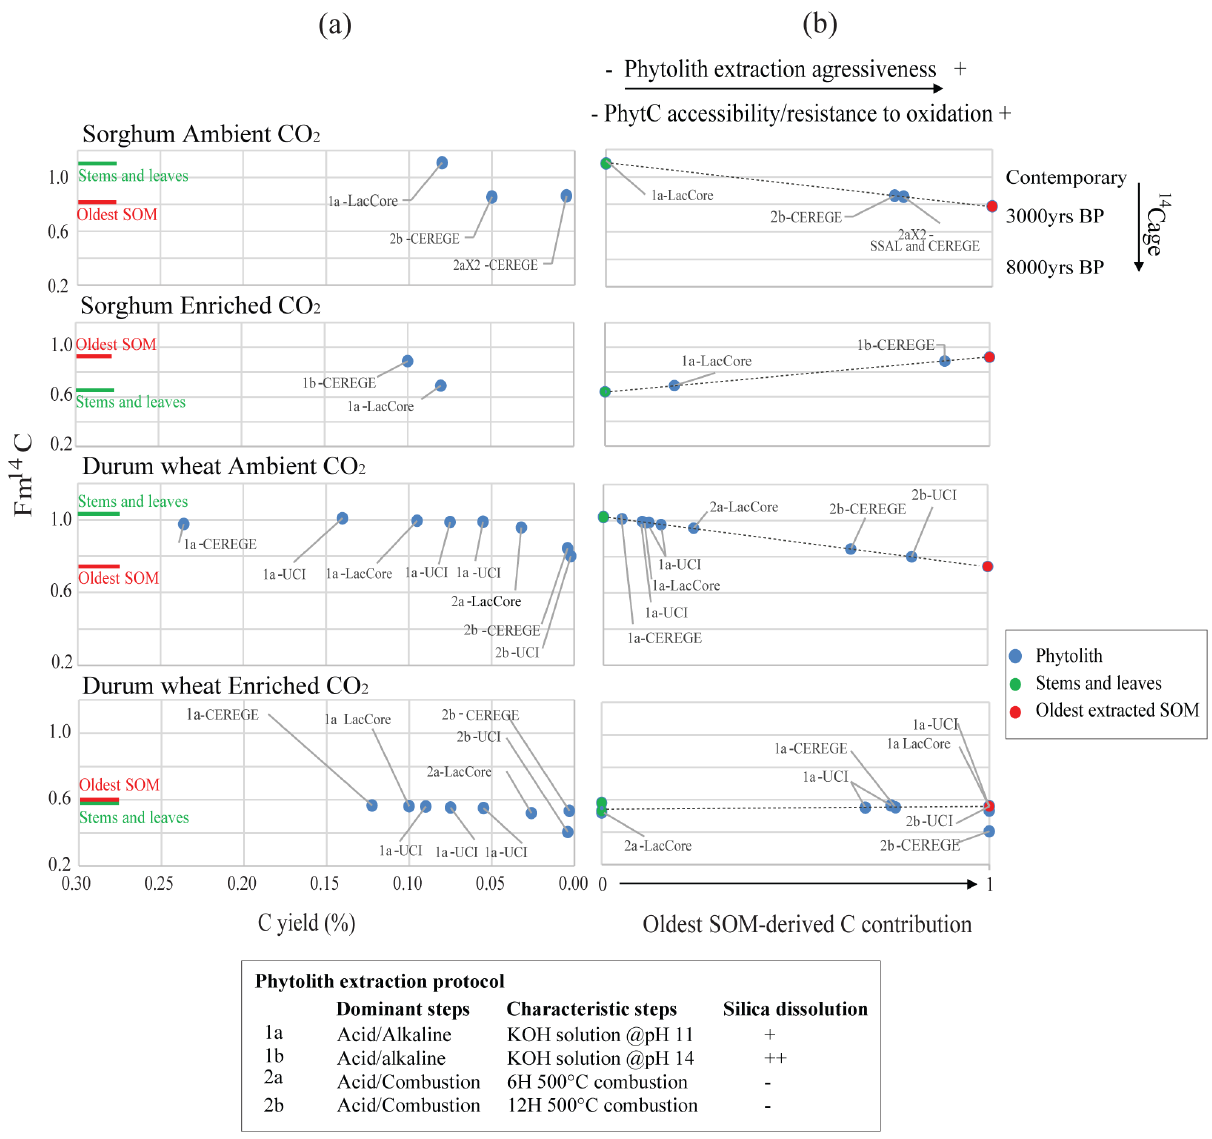
Figure 2. Above-ground C manipulation procedure. (a) Averaged Fm 14 C values versus averaged phytC yields (or concentration in % of phytoliths). Constant solid lines correspond to the averaged Fm 14 C values obtained for stems and leaves (SL) of origin and the oldest extracted SOM fraction. (b) Oldest SOM-derived C contribution to phytC calculated using the mixing equation (Eq. 1) presented in the text expressing the 14 C signature of phytC as the result of mixing between the C derived from plant photosynthesis and the C derived from the oldest extracted SOM fraction. Phytolith samples are labeled according to the extraction protocol (1a, 1b, 2a, 2b described in caption and in the text) used and the laboratory of extraction (UCI, CEREGE, LacCore and